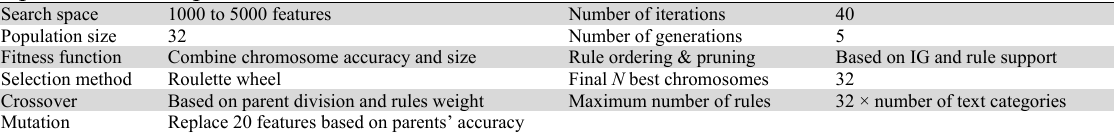
Experimental setup for GARC method